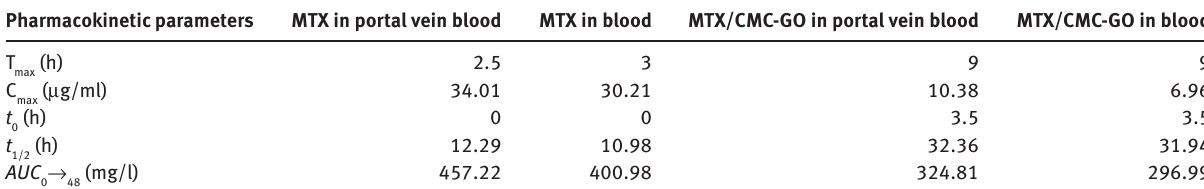
Table 2: Pharmacokinetic parameters for MTX and MTX/CMC-GO. Pharmacokinetic parameters